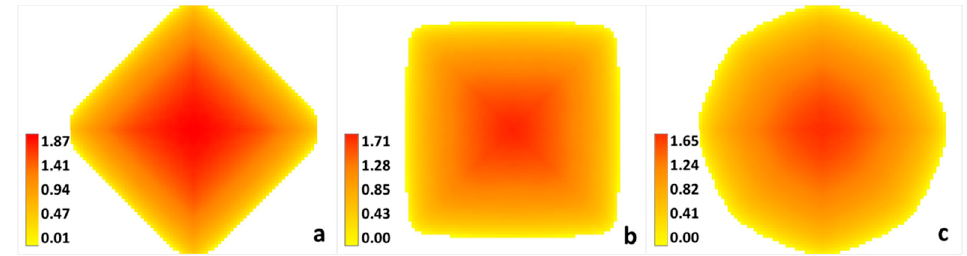
Figure 3. Simulation of a debris flow by collapse on a plane by using a diagonal bias correction of 0 ( a ), 1 ( b ) and 2 − 6 ( c ). Colors represent the flow thickness in